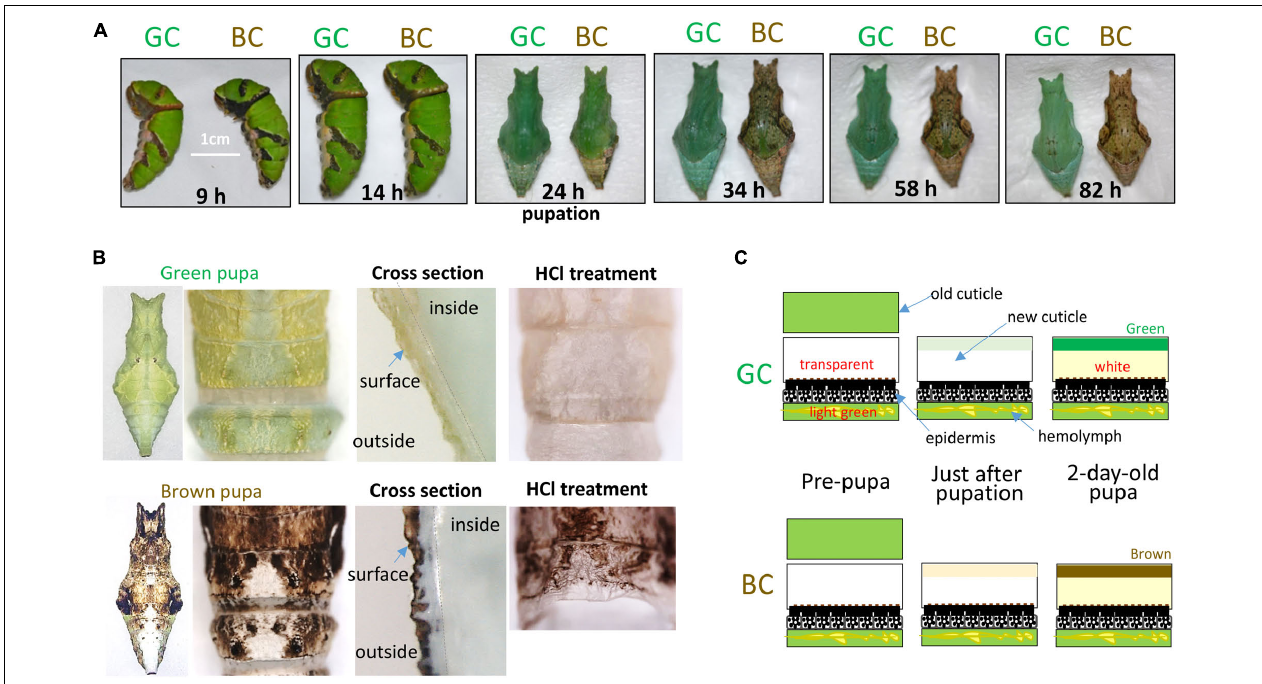
FIGURE 2 | Color change from pre-pupal to pupal stages under green (GC) and brown conditions (BC). (A) Surface color change from pre-pupal to pupal stages. Pupation occurs about 24 h after gut purge (0 h). (B) Cuticle structure and HCl treatment of green and brown pupae. Left: Whole dorsal view and enlarged view of each pupa. Middle: Cross-section of cuticle regions. Right: Dorsal view of pupal cuticle after HCl treatment (see the text). (C) Schematic diagram of cuticle coloration from pre-pupal to pupal stages. Respective cuticle structure and colors under GC and BC are shown with epidermis and